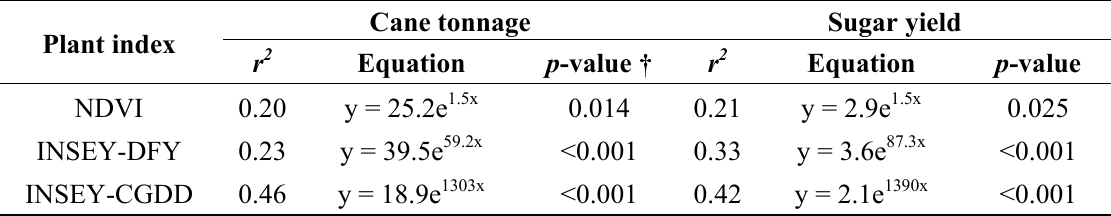
Table 7. Coefficient of determination ( r 2 ), equation, and P -value for relationship between NDVI, INSEY-DFY, and INSEY-CGDD with sugarcane yield component fit with an exponential relationship at 650 through 750